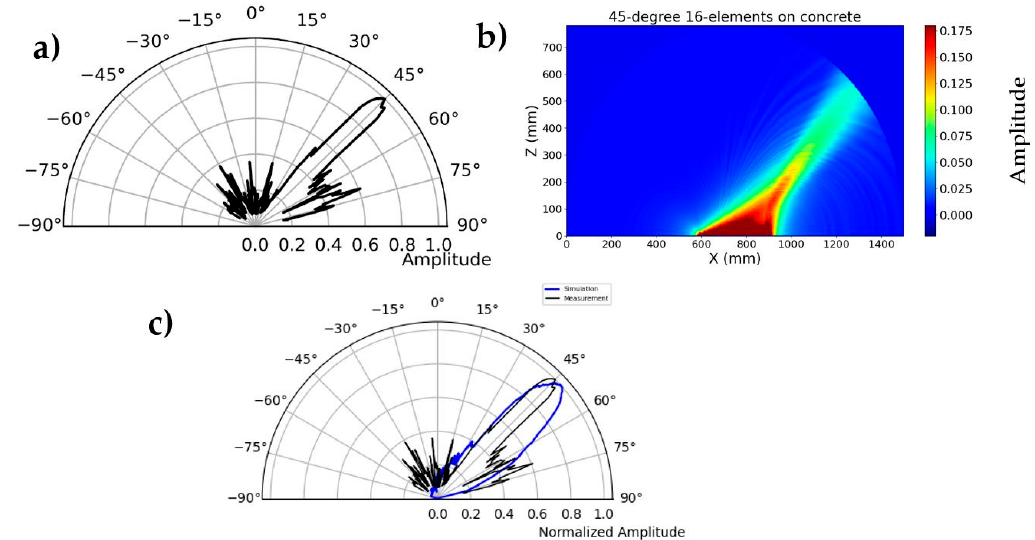
Figure 22 . ( a ) Directivity measurement of third generation borehole probe, focused beam at 45°, ( b ) simulation of borehole probe based on measurement parameters, and ( c ) comparison of simulation and measurement.